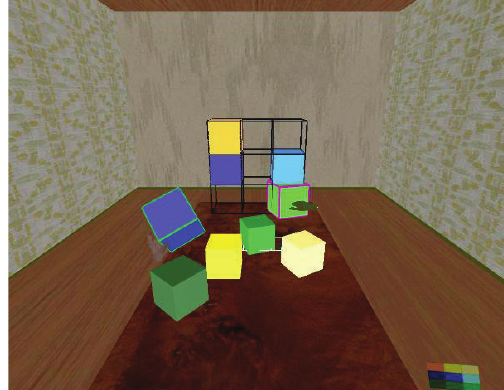
Figure 4: Screenshot of virtual GoGo